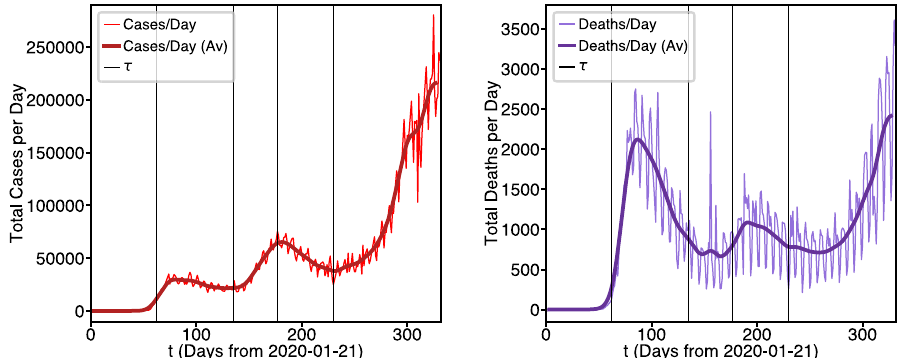
Figure 1. Smoothed cases per day and deaths per day from source data exhibiting inflection